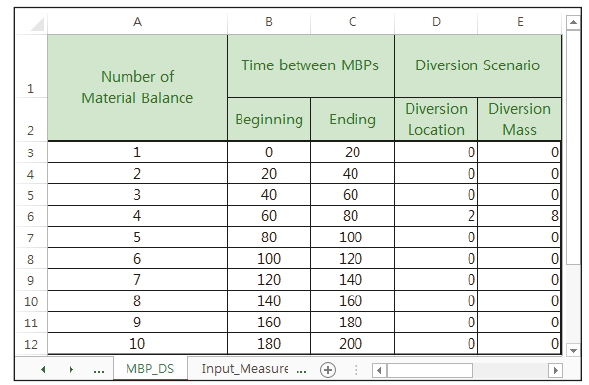
Figure 2: Example of input format (Excel file) for configuration of MBPs and diversion